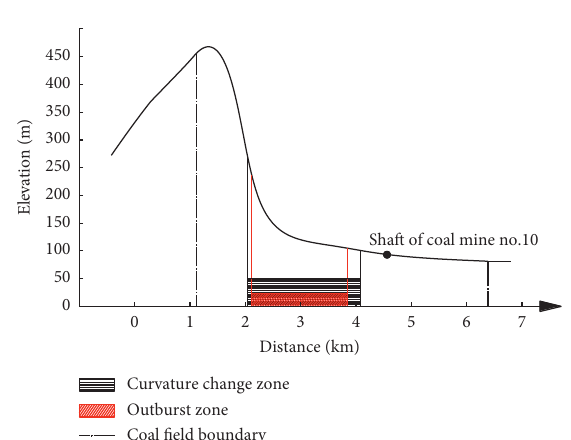
Figure 5: Relationship between terrain curvature change and coal and gas outbursts in mine no. 10.